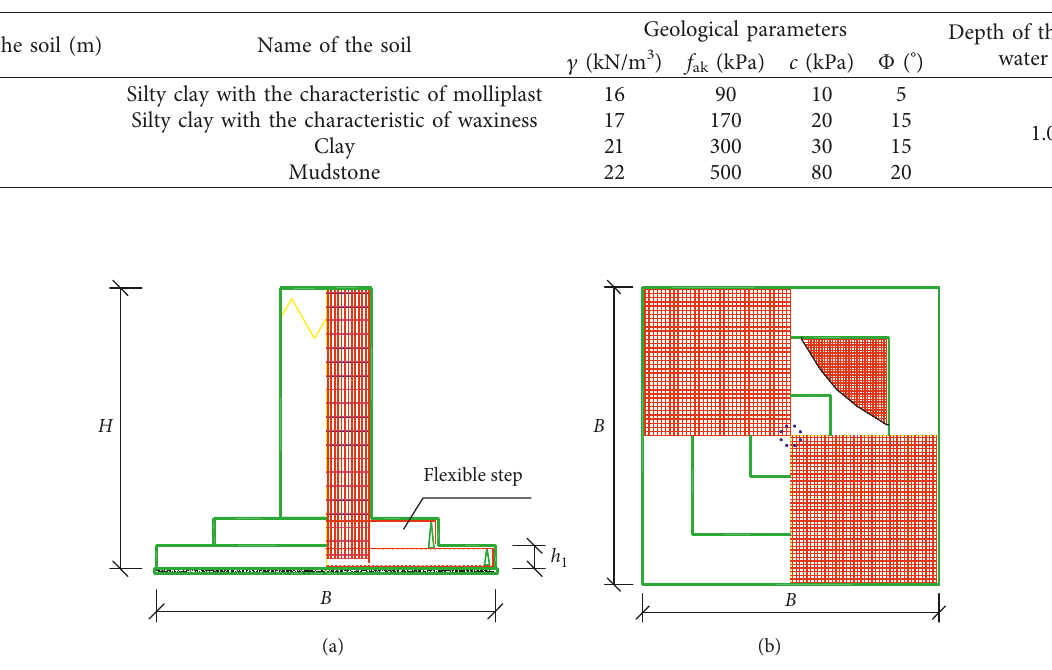
Figure 17: Drawings of the foundation designed by the original method. (a) Elevation of foundation. (b) Plan of foundation. Table 11: Design results by the original